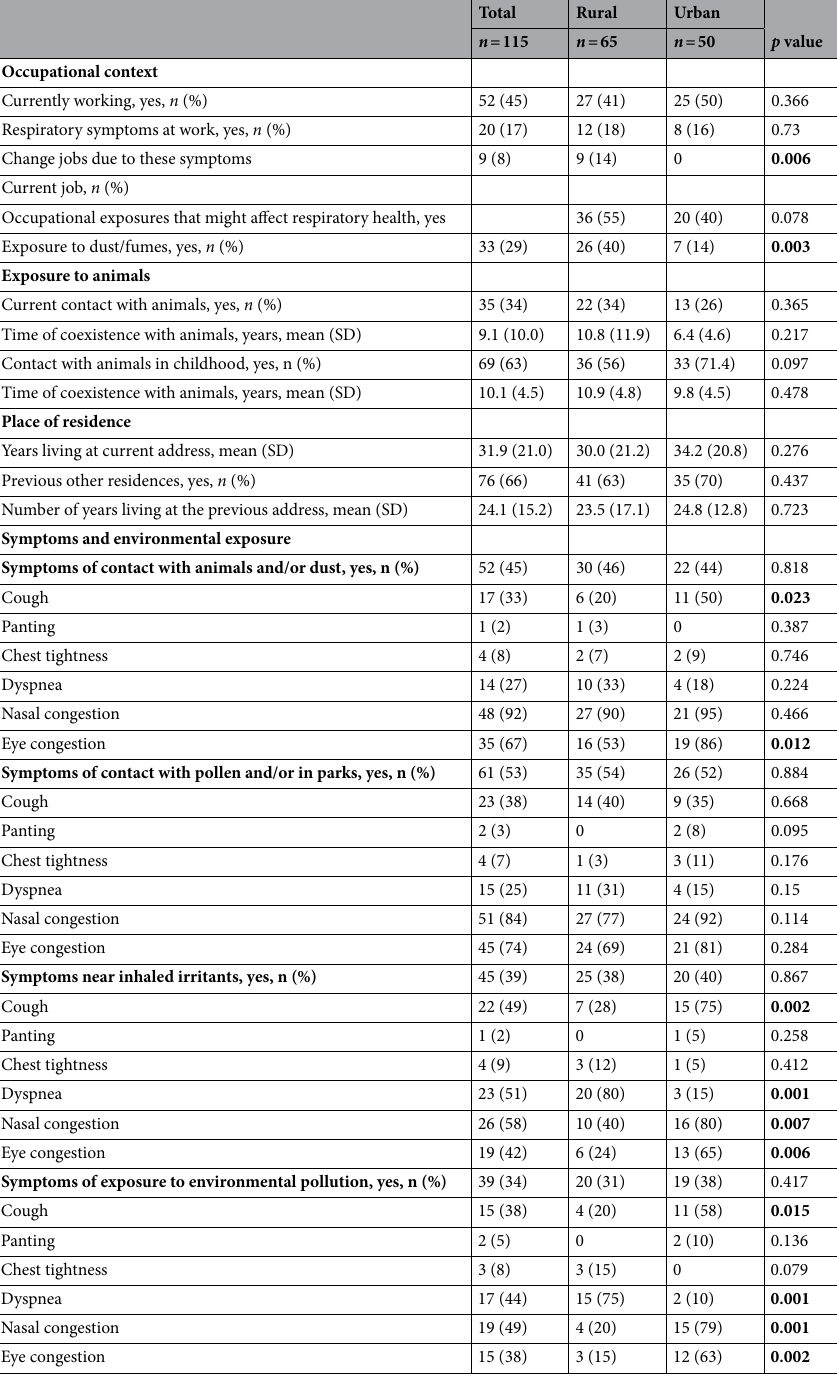
Table 5. Occupational and domestic exposure in the study population. SD Standard deviation. Significant values are in